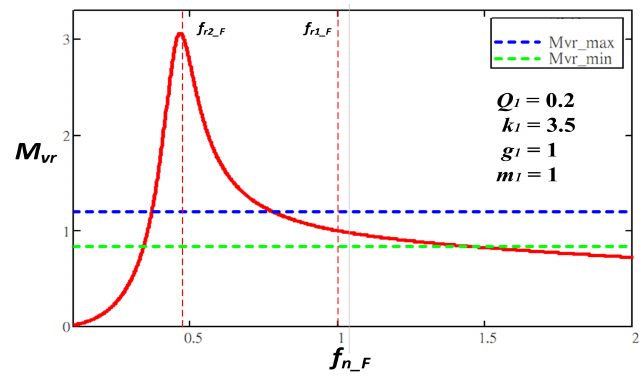
Figure 11. The voltage gain curves operating in the forward charging